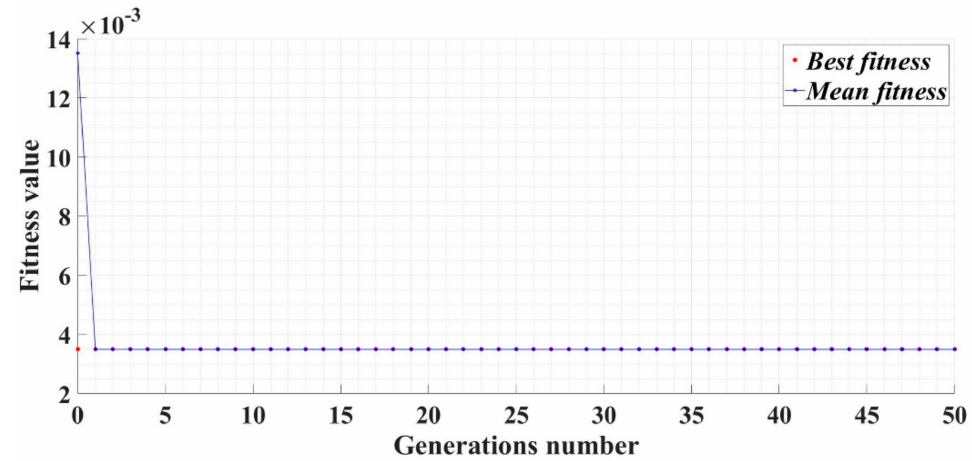
Figure 17. Evolution of the performance of the GA-type